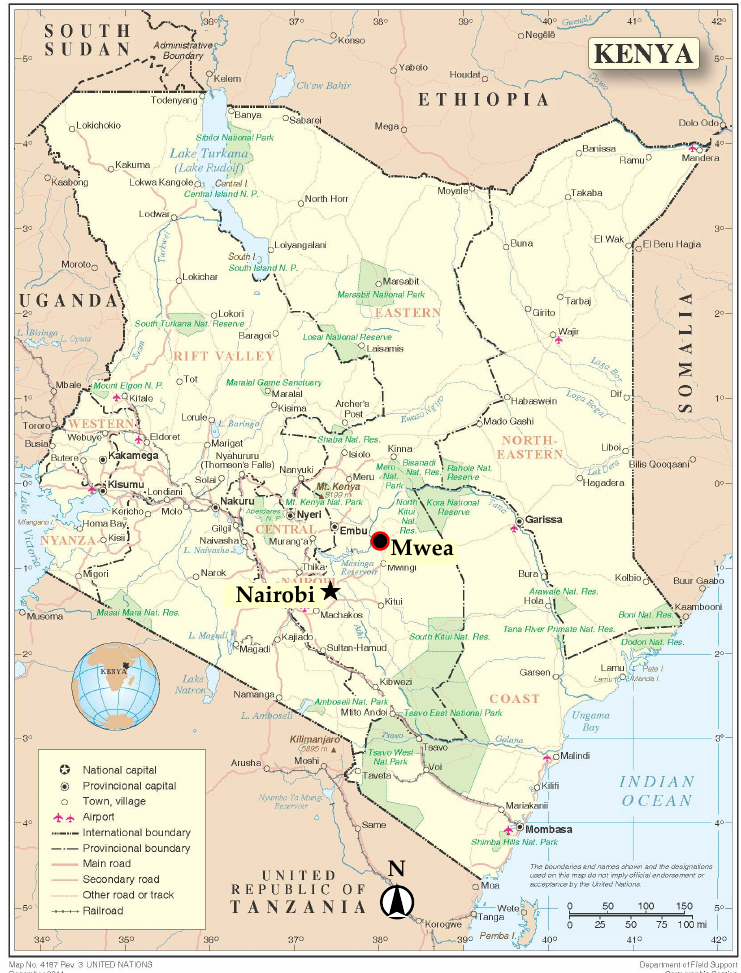
Figure 1. Location map of Nairobi and the Mwea region.